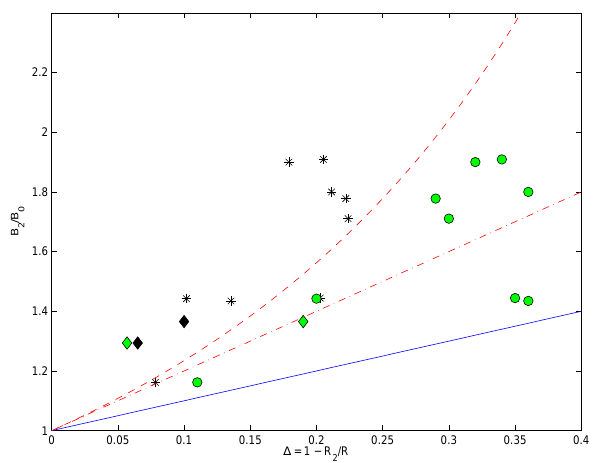
Fig. 12. Theoretical curves for the ratio of the final and initial mag- netic field magnitudes as a function of 1 in the 2-D Collier et al. (1998) model (blue solid line), in 3-D compression, red dashed line, see Eq. (6), and in the case of small 1 for 3-D compression (red dash-dot line). Data points show tail lobe SI events: Stars and cir- cles show the events in this study where we have used the Shue et al. (1998) model and the Petrinec and Russell (1996) model, respec- tively, to approximate 1 . Diamonds show two events presented in Collier et al.